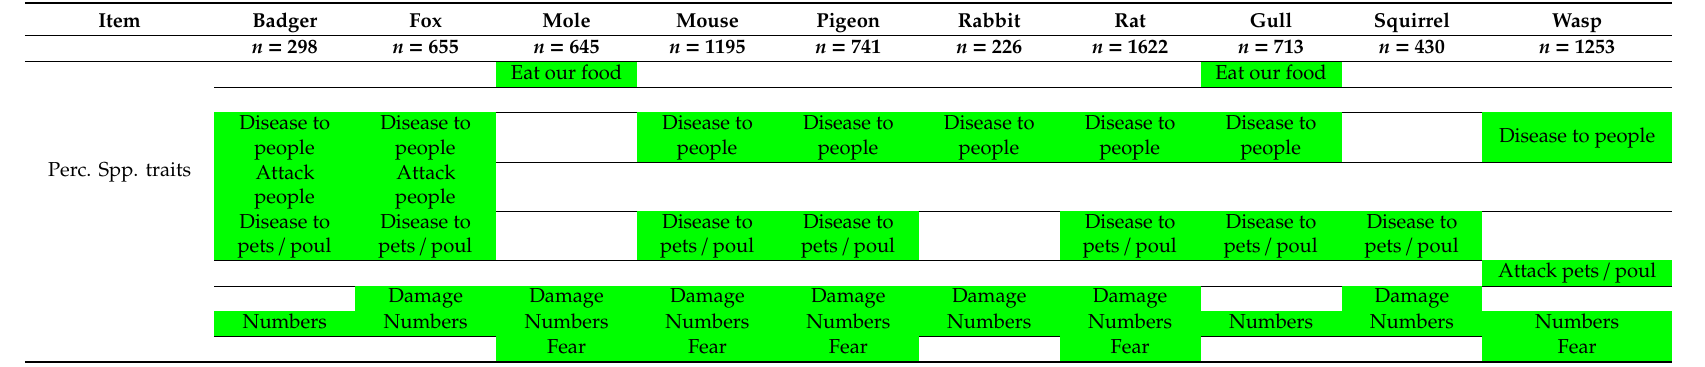
Table 7. Factors associated with people using negative language (‘pest’ or ‘vermin’) to refer to each of 10 species, when they believed that the particular species causes problems for people generally in the UK. Factors are all Perc. spp. traits = ‘Perceived species traits’. Factors shown in green were associated with a greater likelihood of using negative language. See the list of abbreviations for factors in Supplementary Materials Table S2. Item Badger Fox Mole Mouse Pigeon Rabbit Rat Gull Squirrel Wasp n = 298 n = 655 n = 645 n = 1195 n = 741 n = 226 n = 1622 n = 713 n = 430 n =